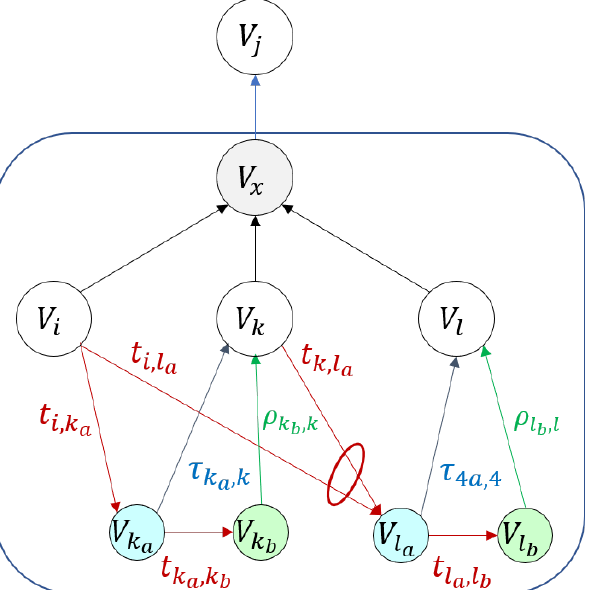
Figure 2. Redundant objects model. Edge attributes are event propagation times: t and ρ are used for source service deterioration, and τ is used for service